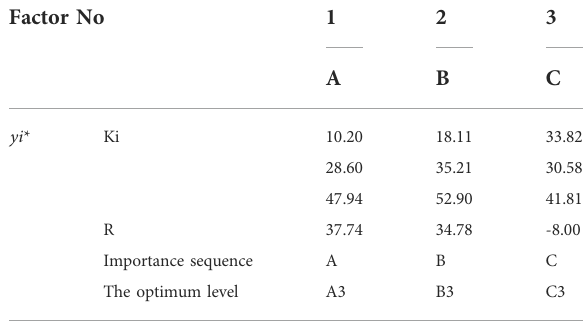
TABLE 5 Results of the orthogonal test of the nasal